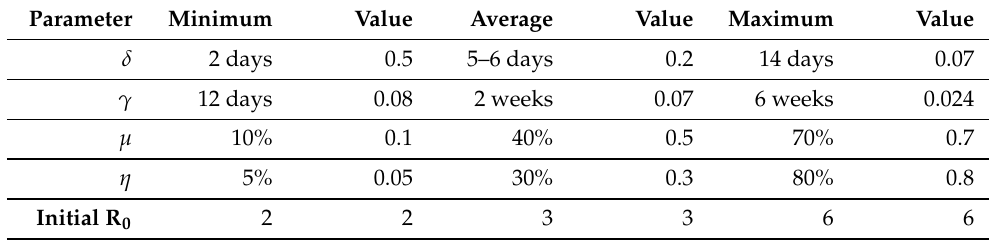
Table 1. Parameter values ranges based on estimated values from CDC and CEBM.